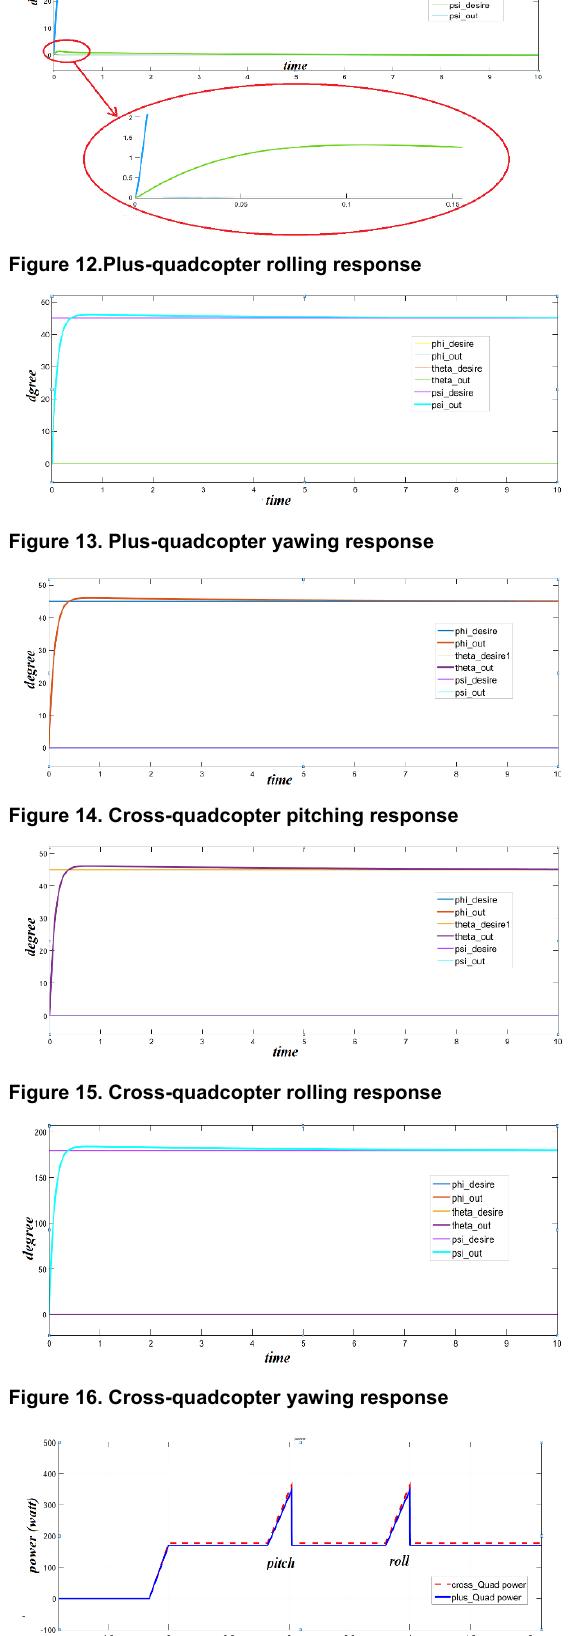
Figure 11. Plus quadcopter pitching response